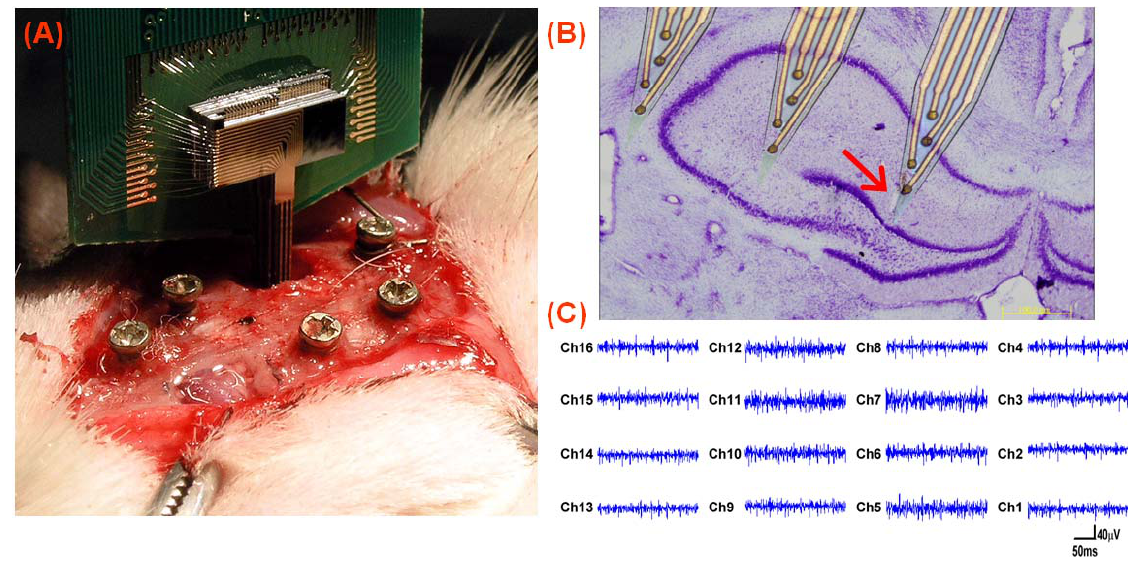
Figure 6. (A) Photograph of a stacked 3-D microprobe array inserted into the brain of an anesthetized rat. (B) The in situ location of microprobe array was shown in the photomicrograph Nissl-stained coronal section. (C) The 16-channel neural activities simultaneously recorded from CA1 in of